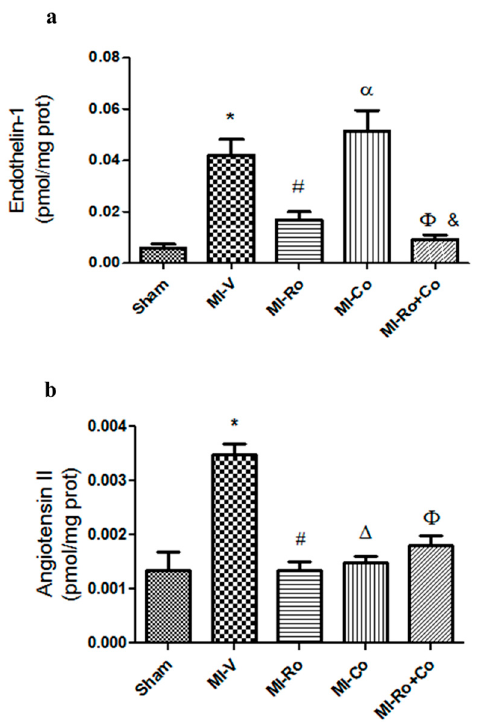
Figure 4. The effect of extracts from Rosmarinus officinalis ( Ro ), Crataegus oxyacantha ( Co ) and their combination ( Ro+Co ) on vasoconstrictor agent levels. Endothelin-1 ( a ) and angiotensin II ( b ) concentration were determined in myocardial ischemic area homogenate from sham, myocardial infarction (MI)-vehicle treated, MI- Ro , MI- Co , and MI- Ro+Co experimental group. The values show the mean ± SEM from six different experiments. p < 0.05 ANOVA one way post Tukey, * Sham vs. MI-V, # MI-V vs. MI- Ro , ∆ MI-V vs. MI- Co , Φ MI-V vs. MI- Ro + Co , α MI- Ro vs. MI- Co , & MI- Co vs. MI- Ro+Co .